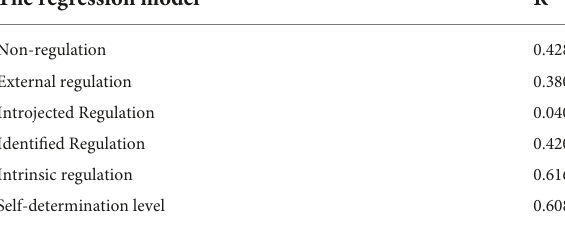
TABLE 9 Summary of R-square